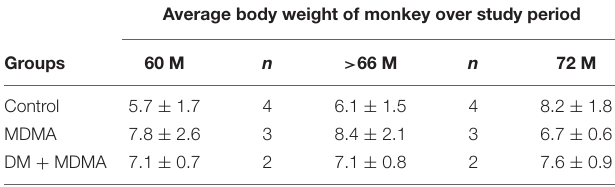
TABLE 2 | Bioinformation on animal body weight during the study period. Average body weight of monkey over study